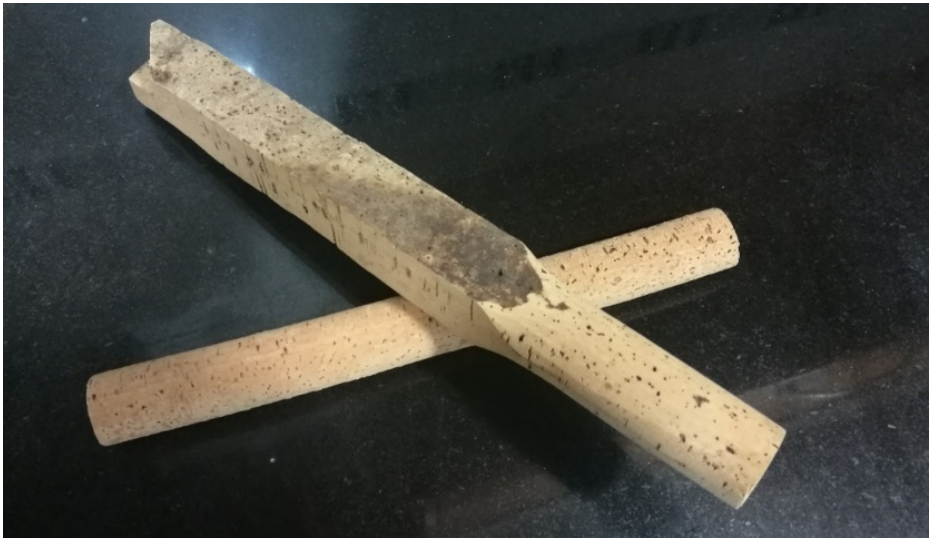
Figure 2. Turning of cork strips (Source: authors).